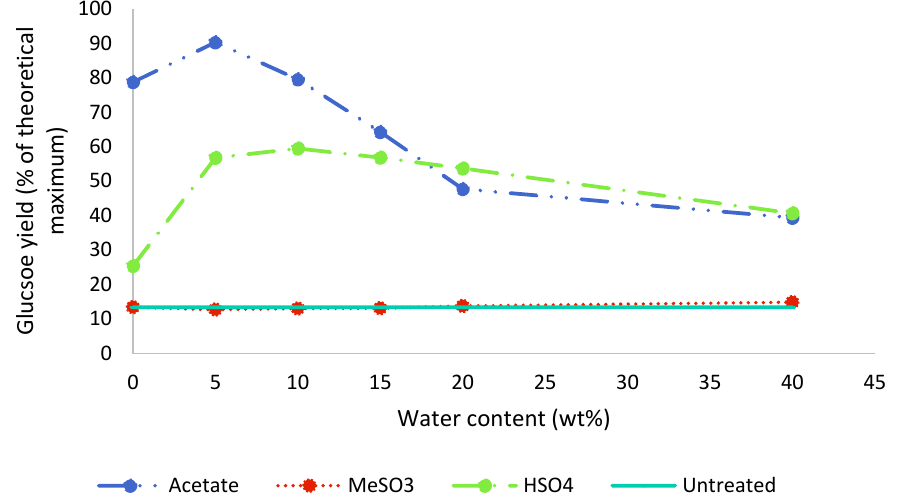
Figure 6. Enzymatic glucose release after 48 h of untreated and pretreated poplar. Poplar was pretreated for 46 h at 100 °C with different [EMim] ionic liquids containing 0–40 wt% water.